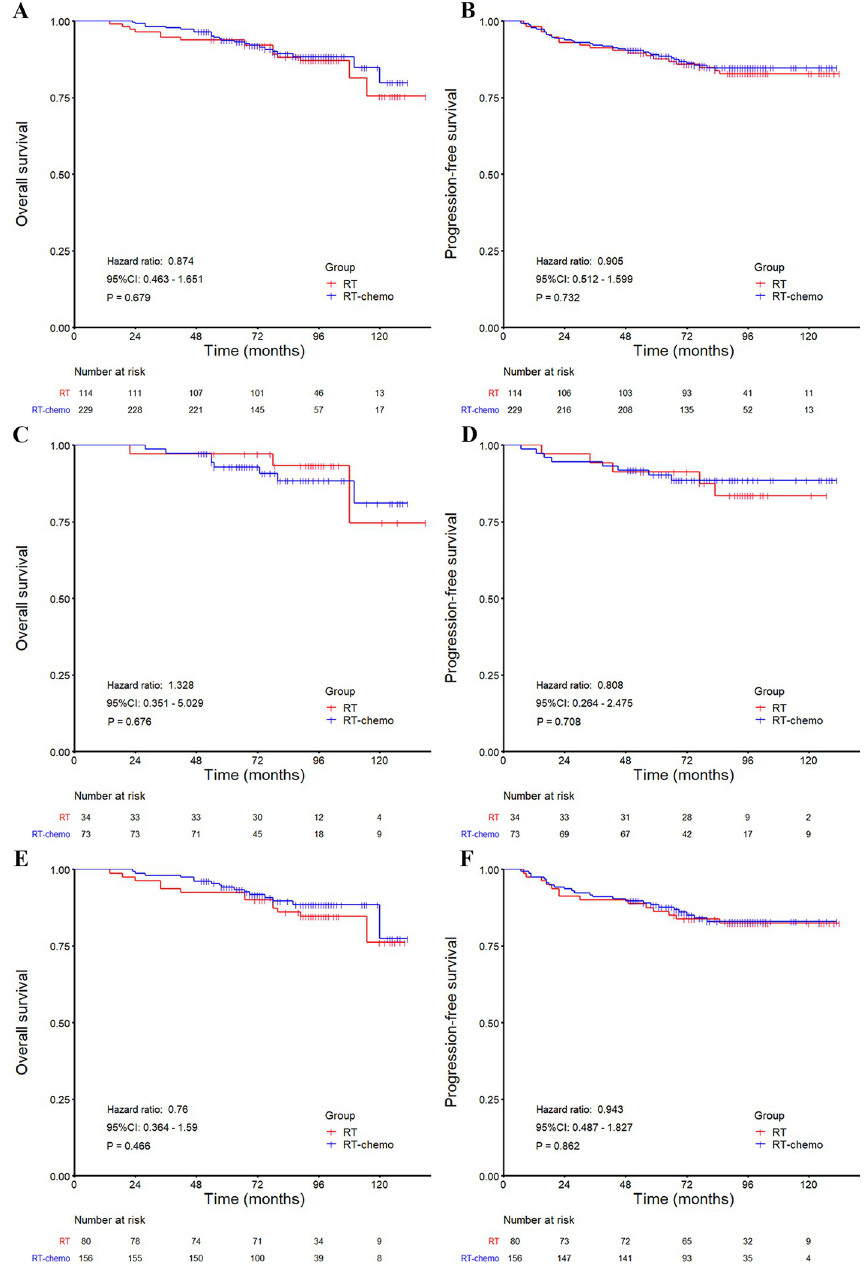
Fig 1. Kaplan–Meier survival curves for the RT and RT-chemo groups. (A–B) whole group analysis: overall survival and progression-free survival, (C–D) T 1 N 1 subgroup analysis: overall survival and progression-free survival, (E–F) T 2 N 1 subgroup analysis: overall survival and progression-free survival. HRs are calculated with an unadjusted Cox proportional hazards model. P values are calculated with the unadjusted log-rank test. CI = confidence interval, RT = radiotherapy, RT-chemo =